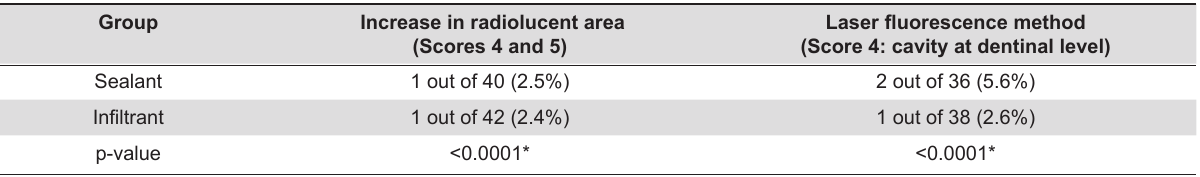
Figure 4- (a) Occlusal aspect of the tooth 27 treated with the infiltrant and clinically followed-up for 3 years; (b) The scanning electron microscopy (SEM) micrograph of the occlusal surface shows a characteristic homogeneous wear pattern, wherein the infiltrate is located below the margins of the oclusal grooves; (c) Higher magnification of the region enclosed by the circle in image b. The infiltrant’s ability to permeate and reach the deepest areas of the occlusal surface is demonstrated. The infiltrant is located in a deeper level in this region, but the tooth remains Table 4- Absolute and relative frequency of clinical caries progression at the end of the study period